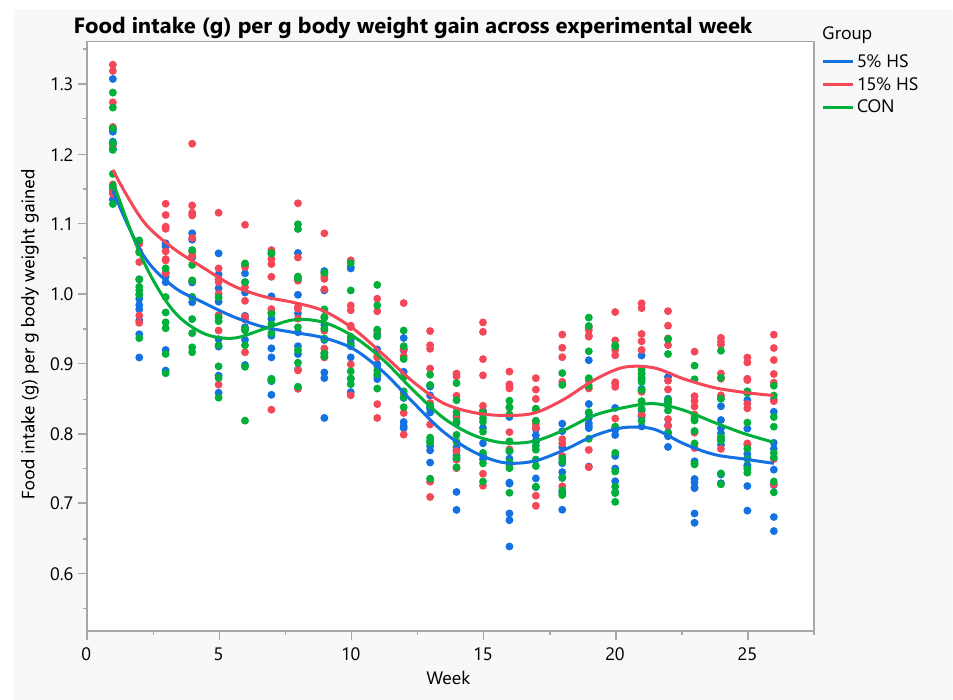
Figure 4. Food intake (g) consumed per g body weight gained across experimental week. N = 8 per group. Each dot represents an individual mouse; colors represent the experimental diet group. Mixed models with repeated measures showed a significant effect of group, with 15% HS consuming significantly more food than the 5% HS and control groups ( p < 0.0001). Effect of week, p <